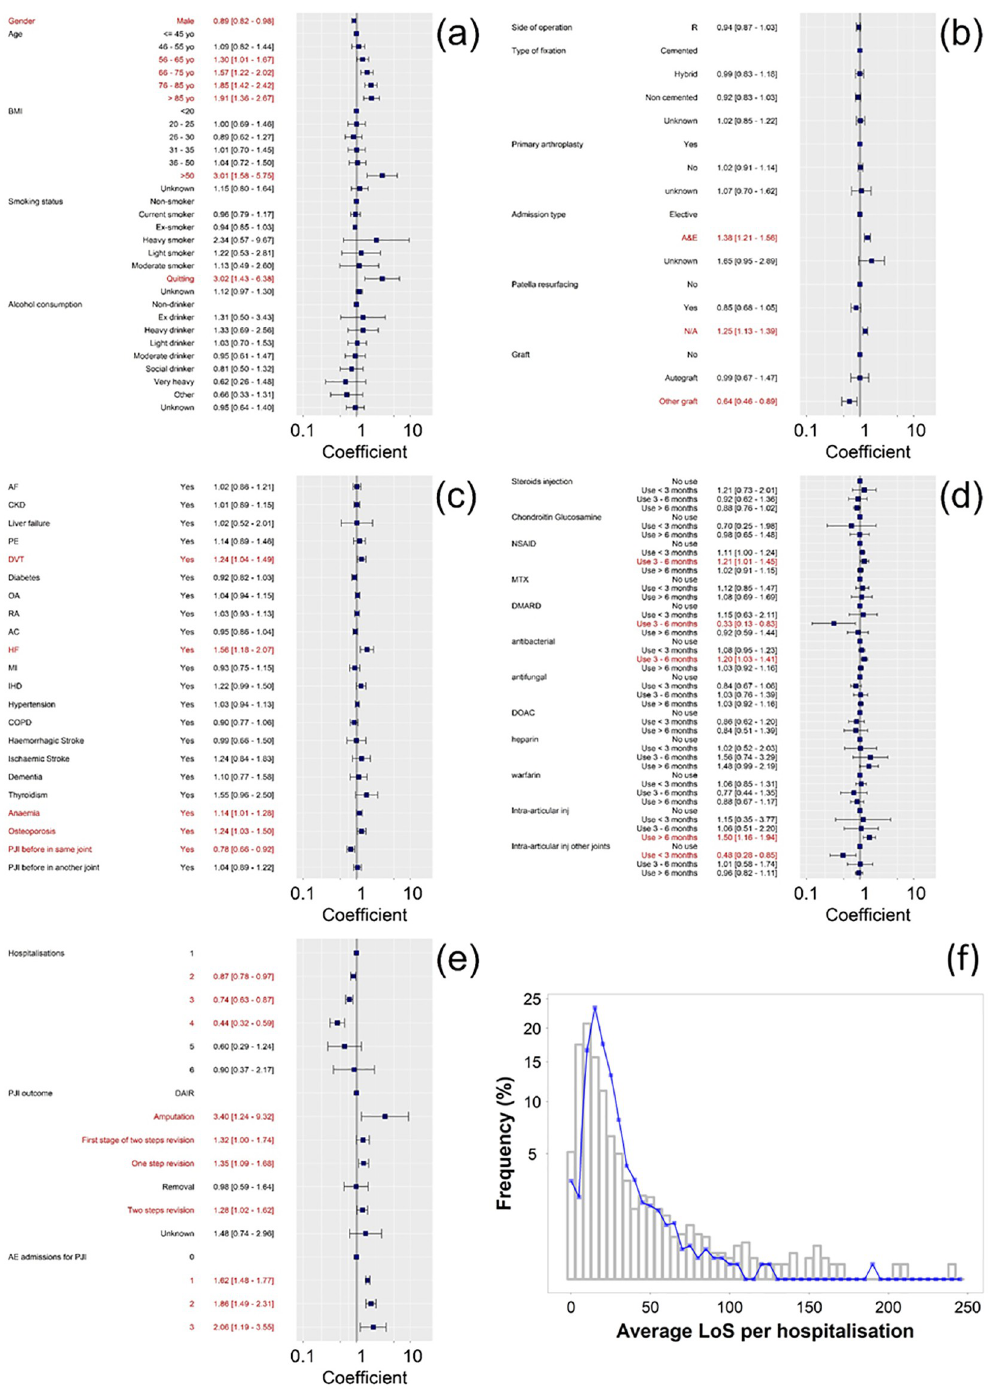
Fig 3. Coefficients for regression of LoS with zero inflated negative binomial distribution for variables related to patient characteristics (a), arthroplasty surgery (b), medical history (c), drug history (d) and PJI characteristics (e). Rootogram of actual LoS and zero inflated negative binomial model predictions